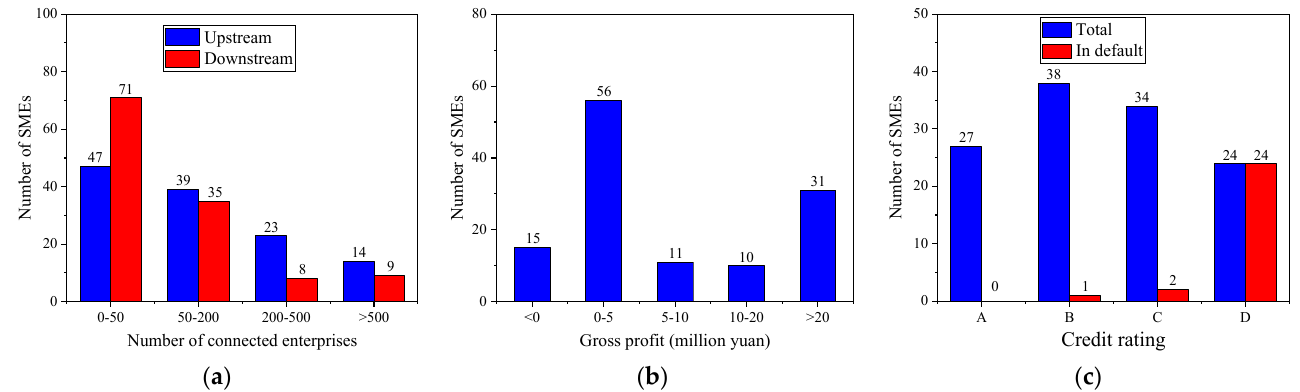
Figure 3. Data from SMEs: ( a ) connected upstream and downstream enterprises; ( b ) gross profit; ( c ) credit rating.